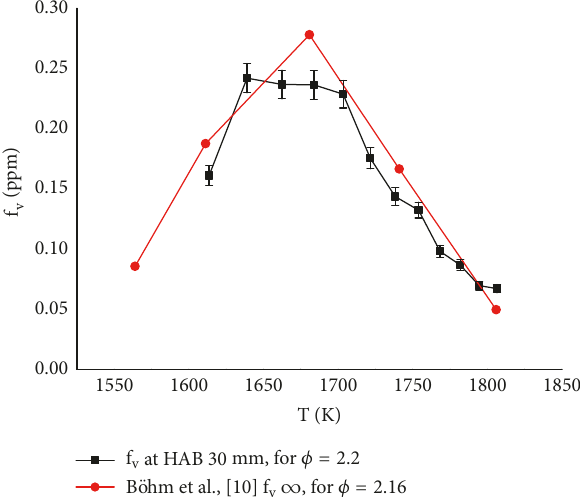
Figure 6: 𝑓 V for 𝜙 = 2.2 at HAB 30 mm as function of temperature (calculated at HAB 5 mm) to final soot volume fractions 𝑓 V ∞ measured in a similar flame ( 𝜙 = 2.16) by B¨ohm et al.